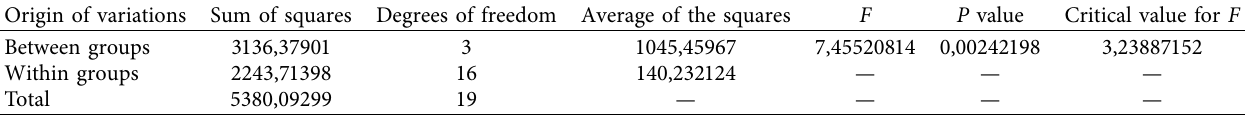
Table 6: ANOVA for the d198 instance.